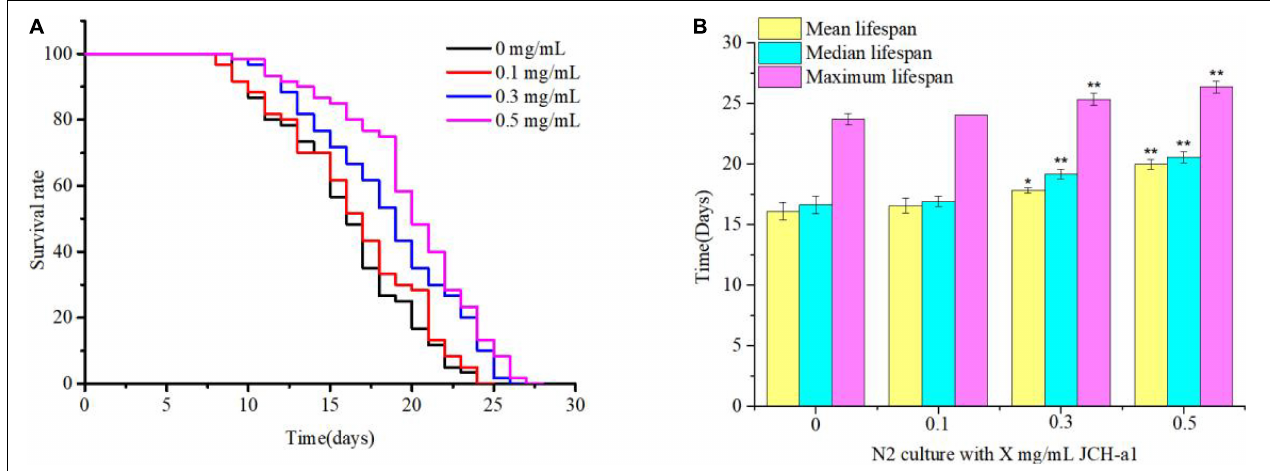
FIGURE 8 | JCH-a1 can extend the lifespan of C. elegans . (A) At 20 ◦ C, C. elegans longevity was cultured at different concentrations of JCH-a1 and survival was monitored. (B) At 20 ◦ C, the mean lifespan, median lifespan and maximum lifespan of C. elegans were cultured at different concentrations of JCH-a1. ∗ represents significant difference ( P < 0.05), and ∗∗ represents extremely significant difference ( P <